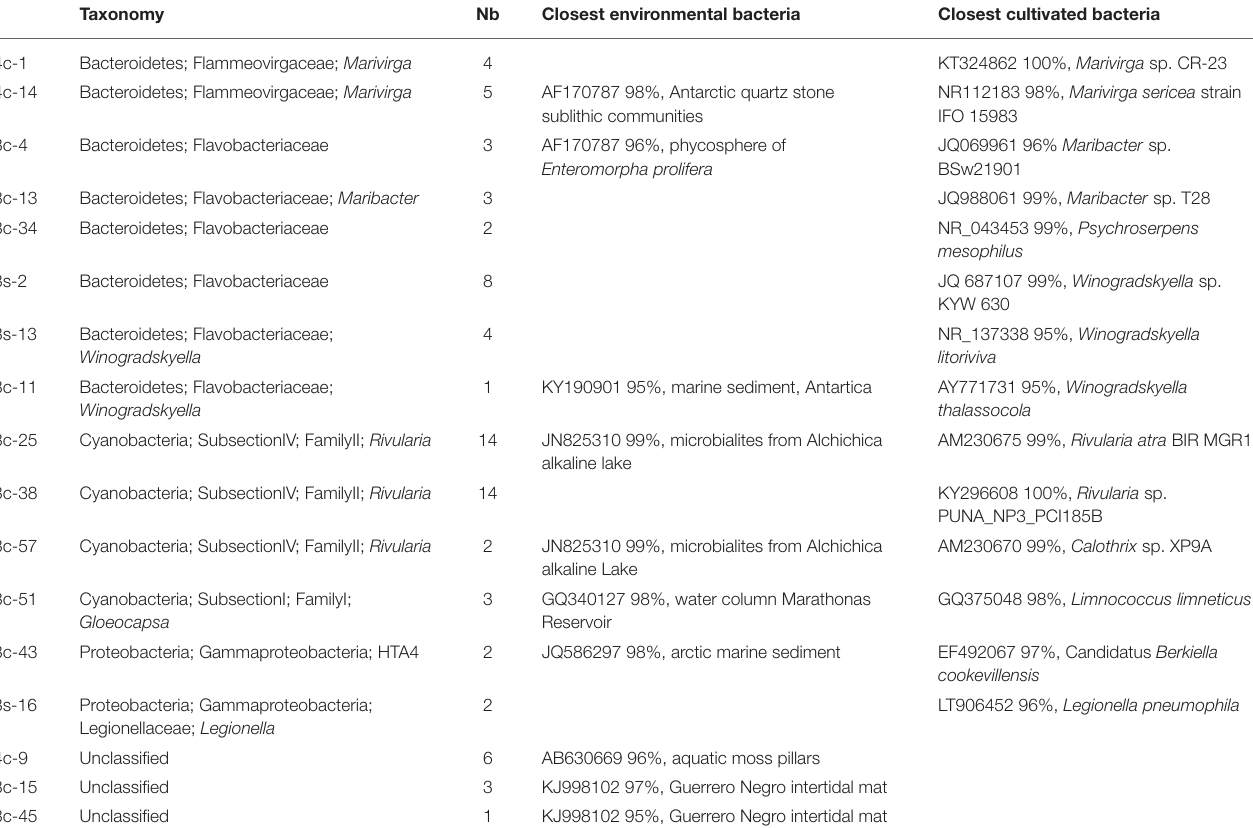
TABLE 1 | Taxonomic affiliations of the bacterial 16S rRNA gene sequences retrieved using general bacterial primers after laser microdissection from the BP consortia collected in 2015. Taxonomy Nb Closest environmental bacteria Closest cultivated